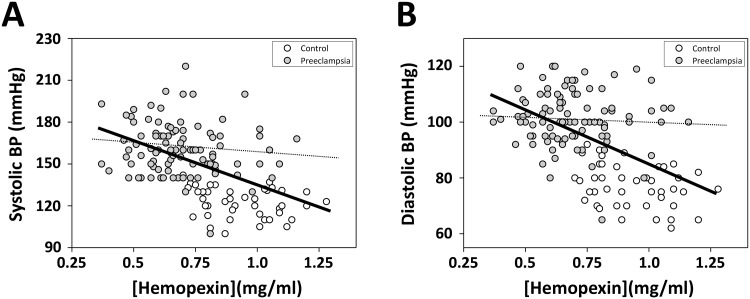
Correlation between Hpx concentration and systolic/diastolic blood pressure.Highest systolic (A) and diastolic (B) blood pressure (BP) measured within the last two weeks before delivery were plotted against the plasma concentration of Hpx. Correlation analysis of PE patients and controls using Pearson’s correlation coefficient between Hpx and blood pressure, systolic (A, solid line; r = -0.511, p-value<0.00001, n = 145) and diastolic (B, solid line; r = -0,520, p-value<0.00001, n = 145). Correlation analysis of PE patients only using Pearson’s correlation coefficient between Hpx and blood pressure, systolic (A, dashed line; r = -0,123, p-value 0.22, n = 98) and diastolic (B, dashed line; r = -0,058, p-value 0.57, n = 98).